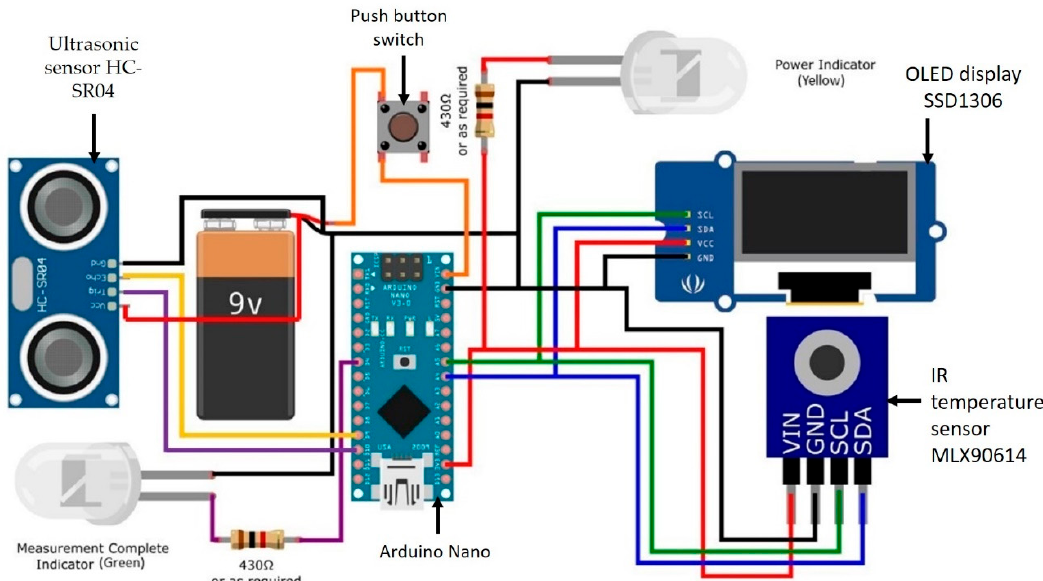
Figure 2. A circuit schematic of the assembled digital IR thermometer consisting of: Ultrasonic sensor HC-SR04, push button switch, Arduino Nano board, OLED display SSD1306, and IR temperature sensor MLX90614.